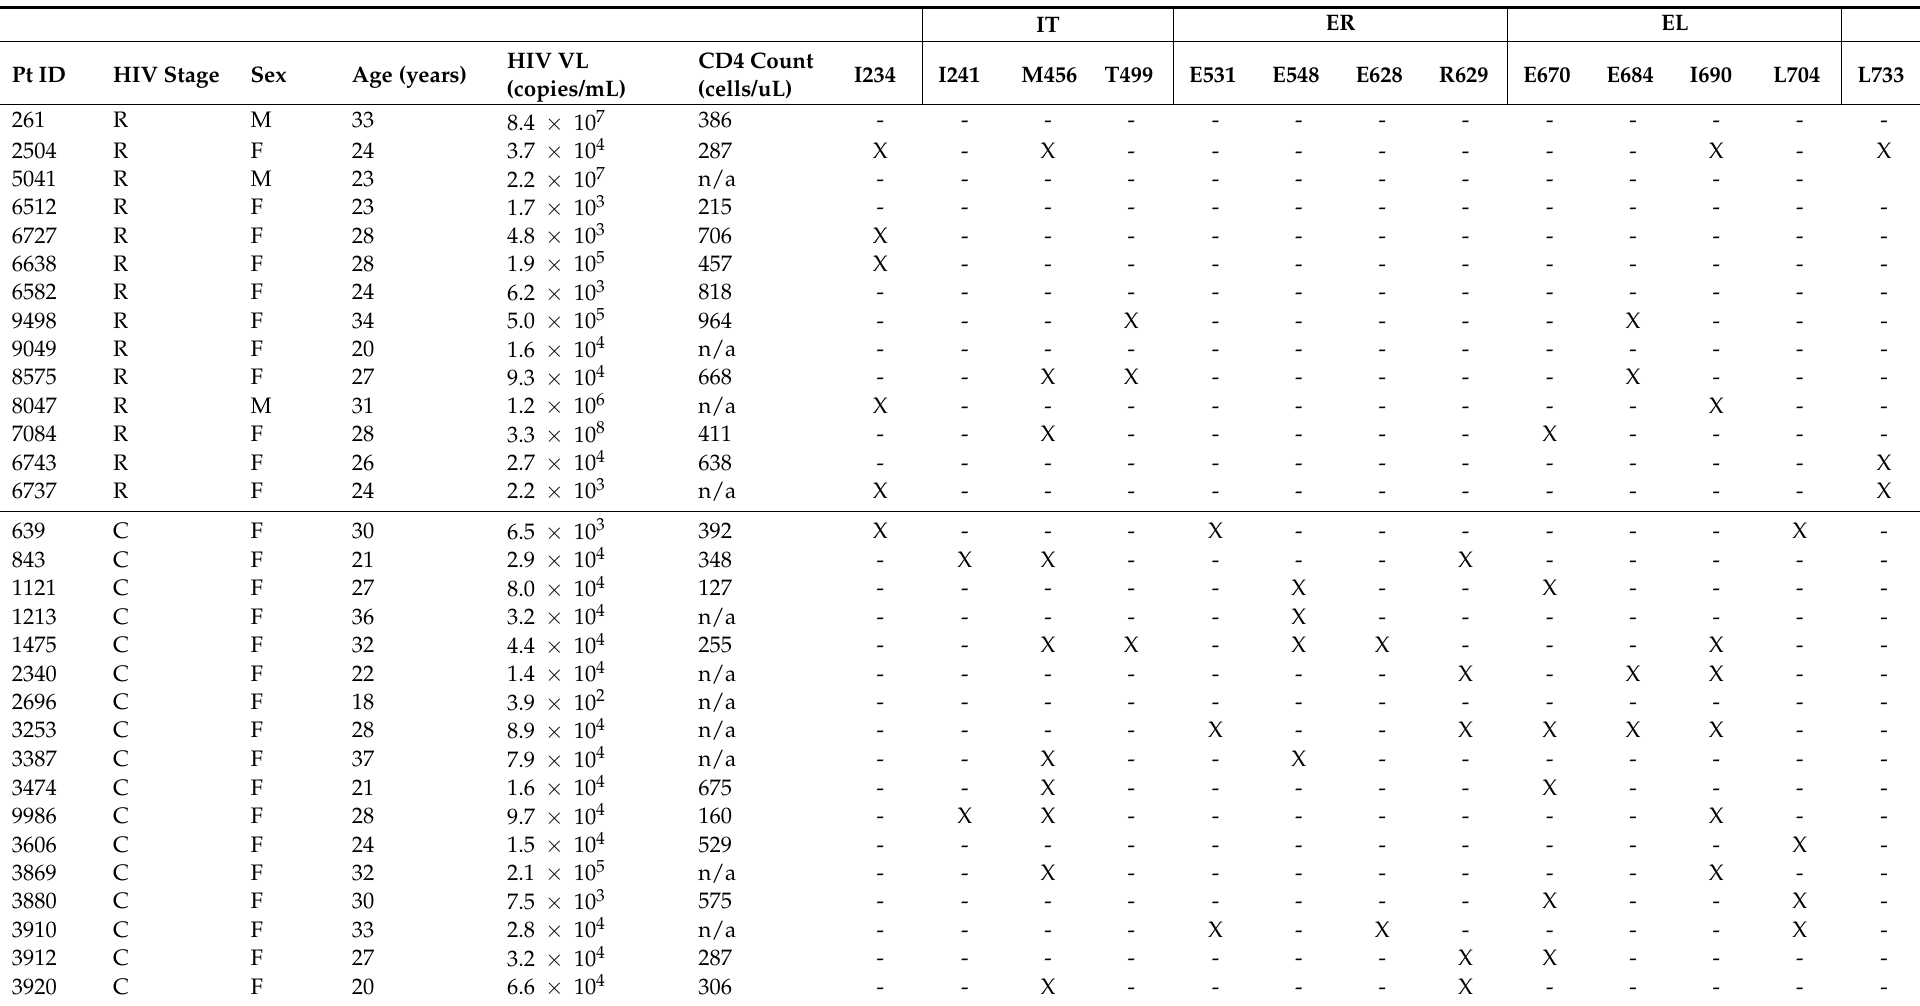
Table 1. Demographics and summary of the amino acid mutations found to have a different distribution between recent and chronic infection